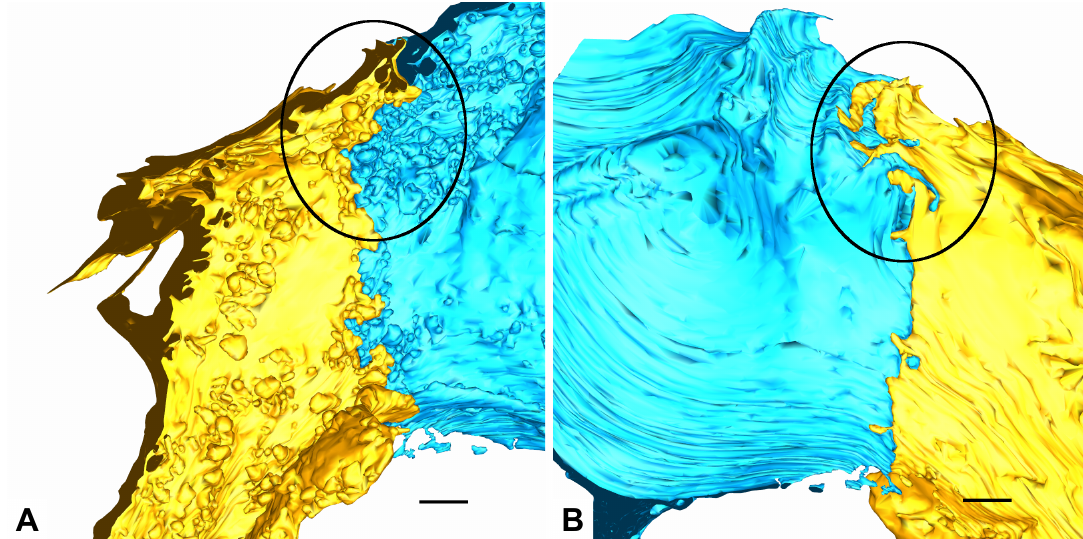
Figure 9. AE1/AE1 contact. ( A , B ) again show the yellow and blue AE1 cell domain from a luminal ( A ) and a basolateral ( B ) perspective but without transparency. Note the irregular contact site on the abluminal side compared to the luminal side caused by interdigitating cell processes. Compare in particular the region emphasized by the ellipse. Scale bars: 1 µ